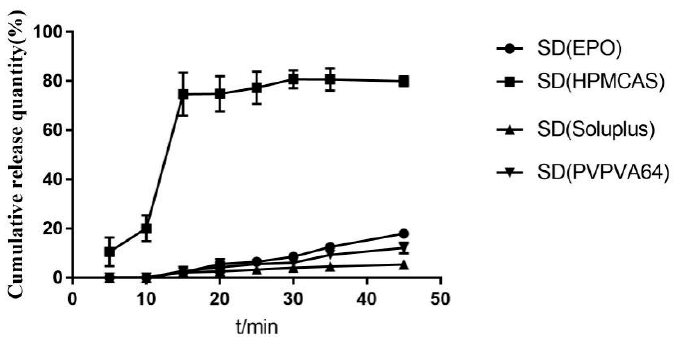
Figure 2. Dissolution curves of solid dispersion prepared by different carrier.